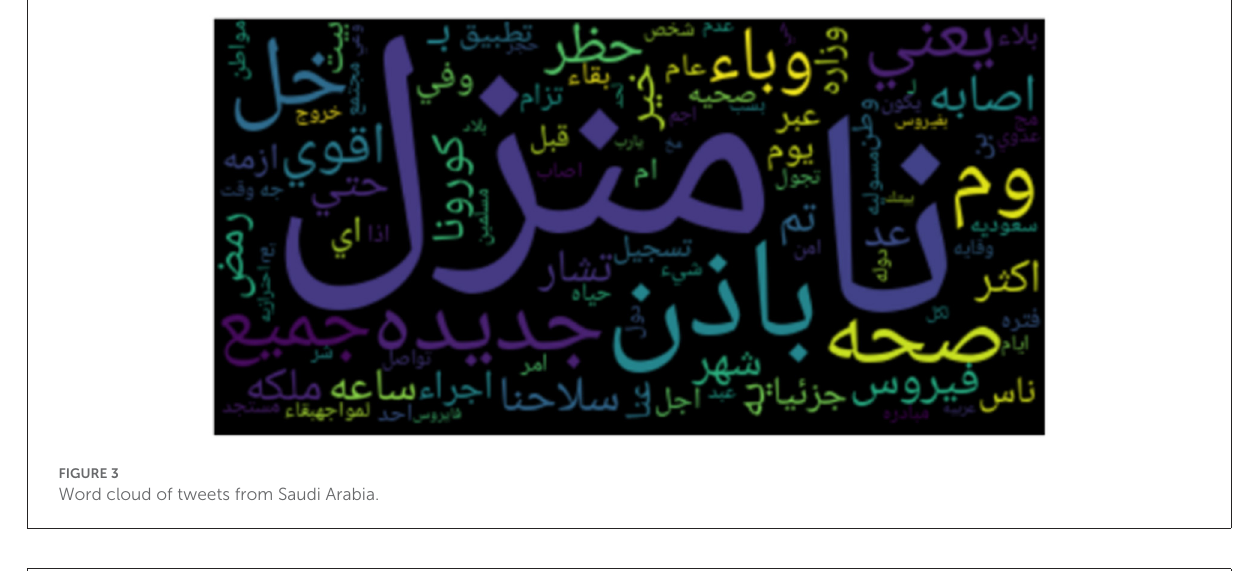
FIGURE3 Word cloud of tweets from Saudi Arabia.